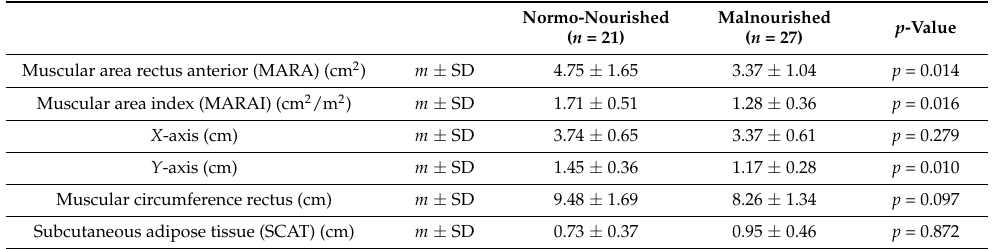
Table 5. Differences between muscle ultrasound parameters according to nutritional